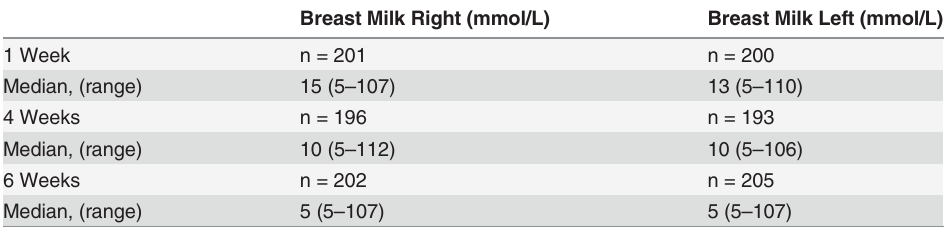
Table 3. Sodium Concentration in Bilateral Breast Milk Samples from 273 HIV-Infected Women. Breast Milk Right (mmol/L) Breast Milk Left